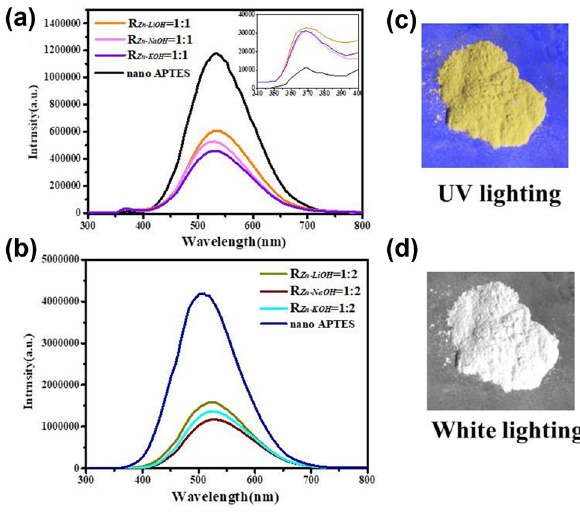
Figure 8: Solid - state fl uorescence spectra of ZnO QDs synthesized under di ff erent alkali bases and di ff erent R Zn − OH = 1:1 ( a ) , R Zn − OH = 1:2 ( b ) , and fl uorescence of di ff erent alkaline and R Zn − OH ratios under UV irradiation ( c and d )